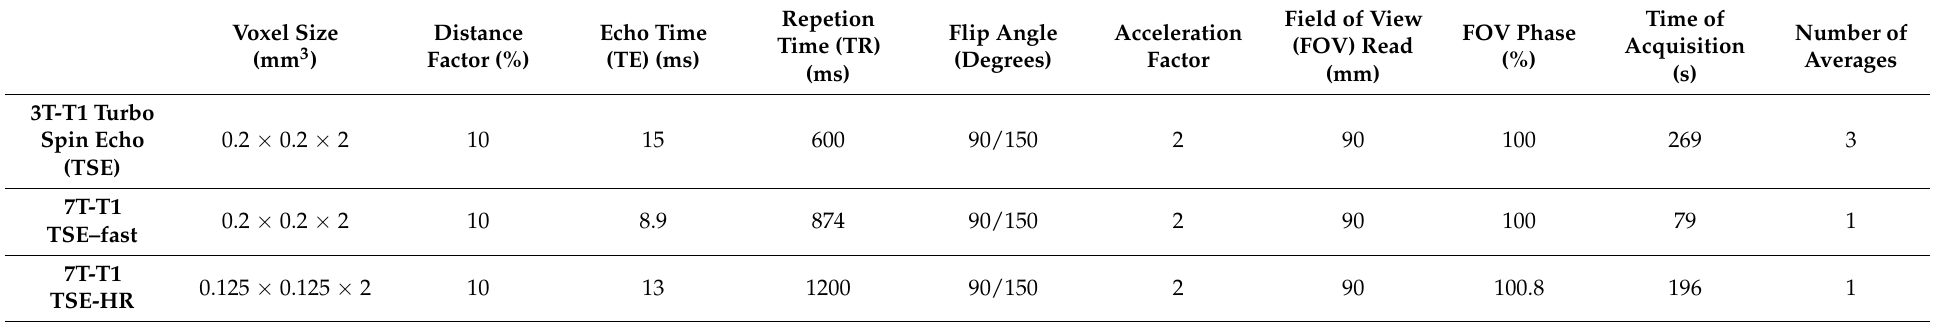
Table 1. MR imaging parameters for each